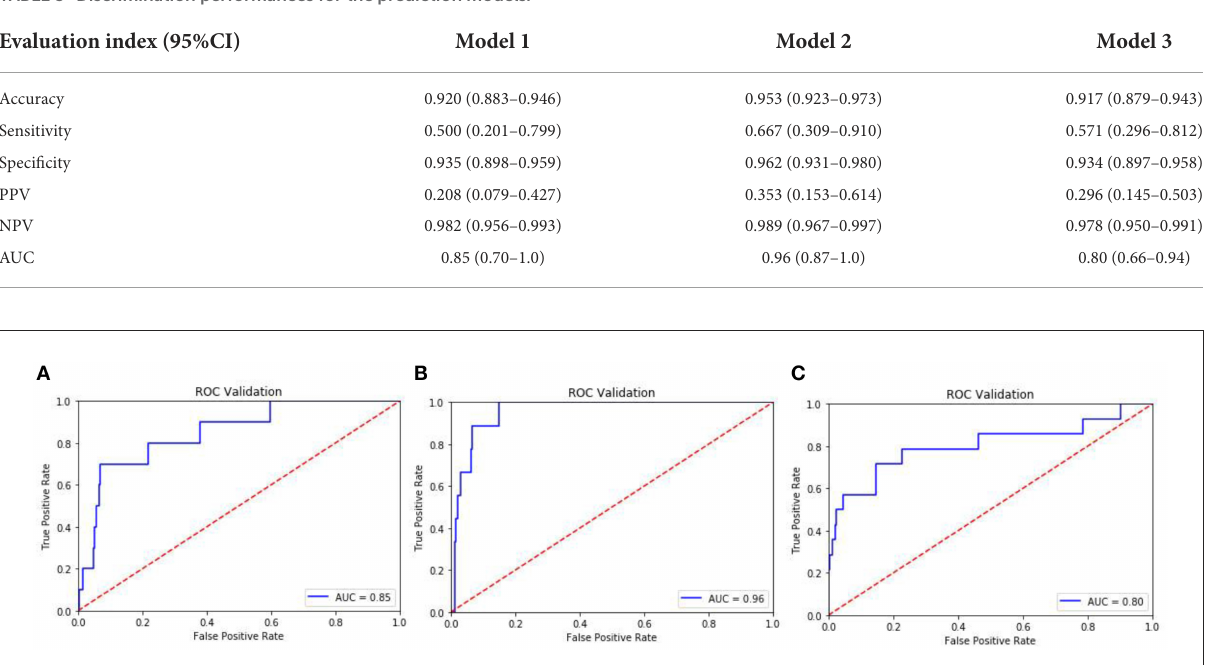
FIGURE1 The ROC curves of the testing set. (A) ROC curve of the testing set in model 1. (B) ROC curve of the testing set in model 2. (C) ROC curve of the testing set in model